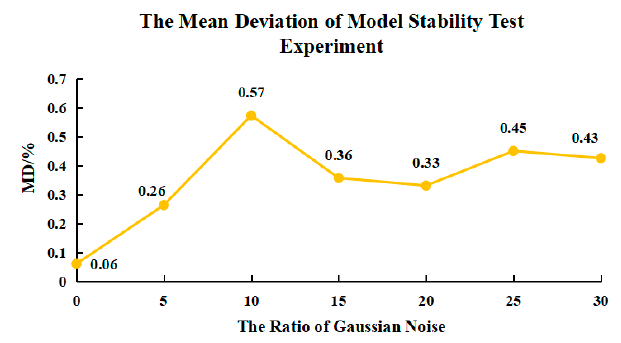
Figure 16. MD of the results for the model stability evaluation.